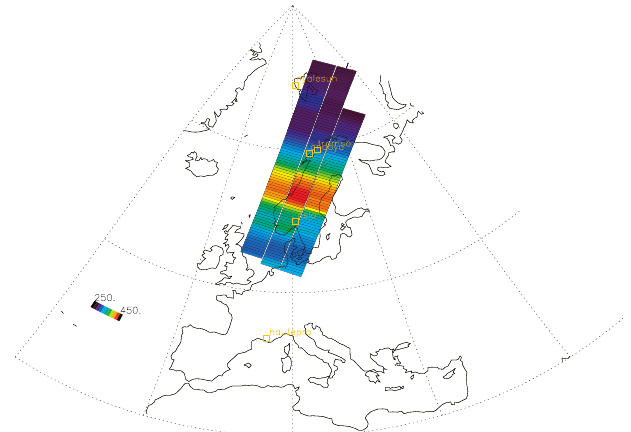
Fig. 8. GOME measurements of total ozone over Scandinavia and Svalbard on April 2, 1997 around local noon. The sharp gradient above north Norway coincides with the edge of the polar stratospheric vortex. Colour scale in Dobson